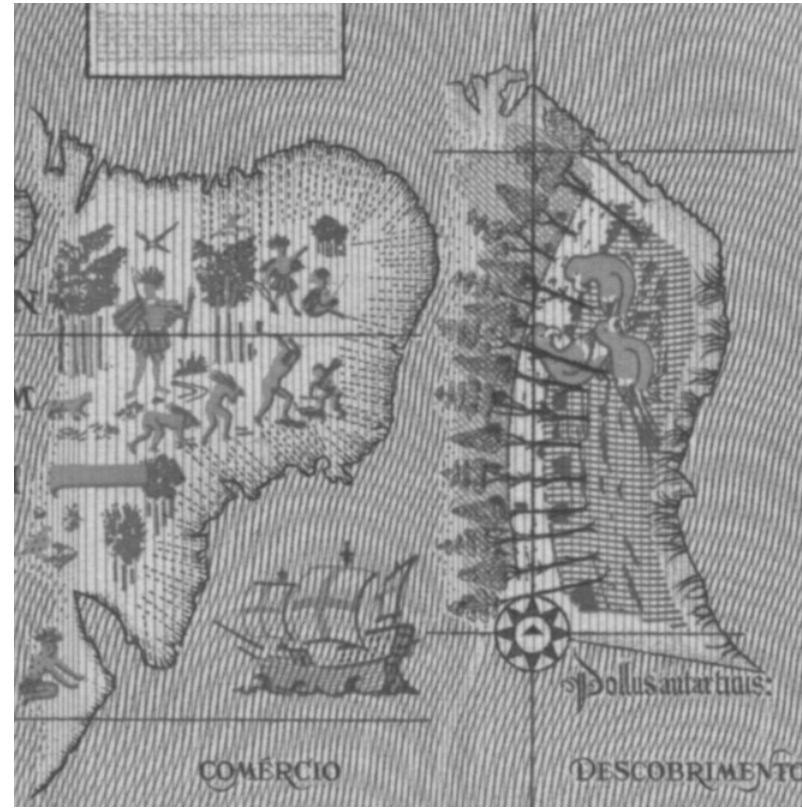
Fig. 3 – Part of one side of the commemorative bill of five hundred cruzeiros (1972) with Cantino’s map which represents the Brazil discovery, right, and the Carta do Brasil which represents the commercial use of Brazilwood,